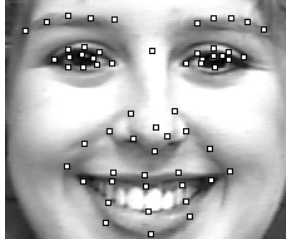
Fig. 1. Facial feature points denoted by white squares (this facial image is from Cohn-Kanade AU-Coded Facial Ex- pression Database 12 ).